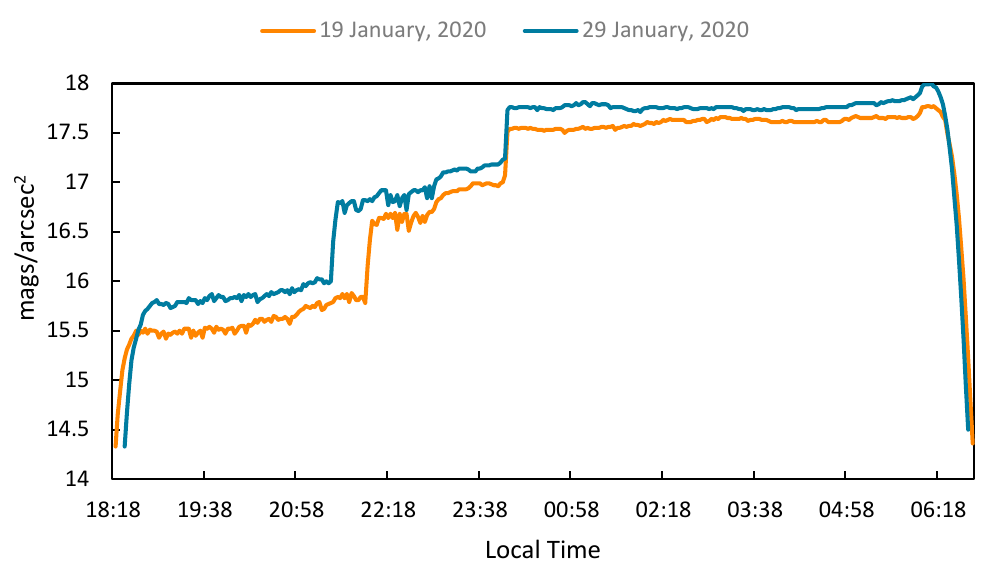
Figure 4. The night-time sky brightness series of Guangbutun region obtained with the SQM device. Note that 19 January 2020 is prior to the COVID-19 lockdown and 29 January 2020 is during the lockdown.